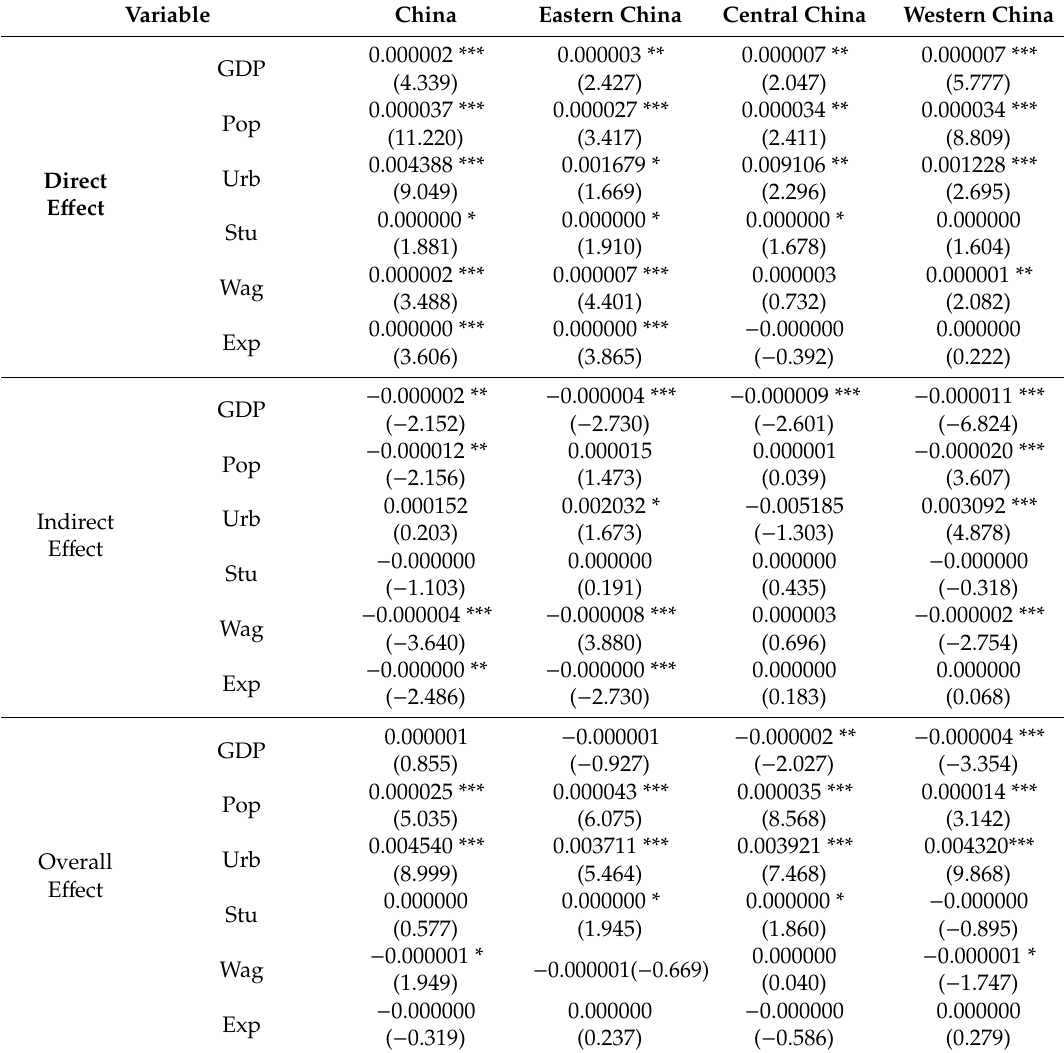
Table 6. Direct, Indirect, and Overall E ff ects of Factors A ff ecting HCR concentration in China. Variable